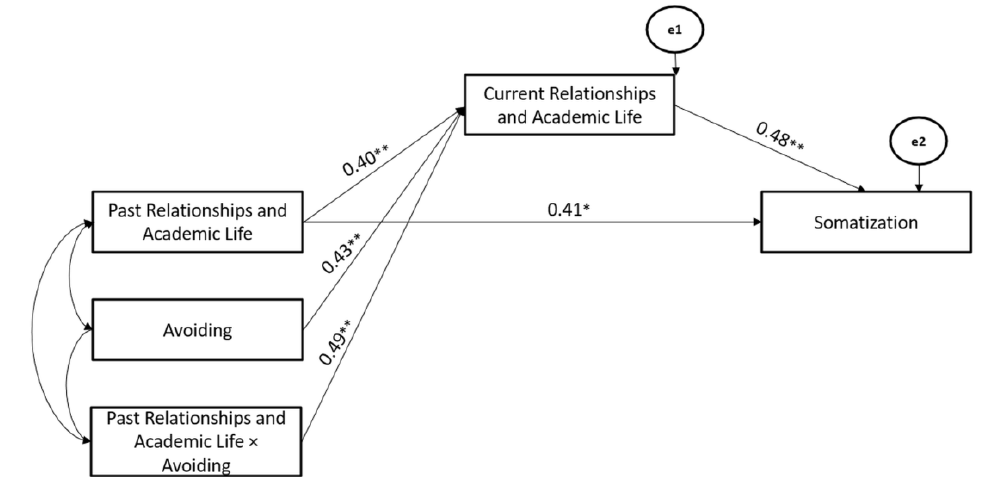
Figure 4. The Mediated-Moderated model of Past and Current Relationships and Academic Life stressors, Avoiding Coping Strategy, and Somatization. ** p < 0.01; * p <